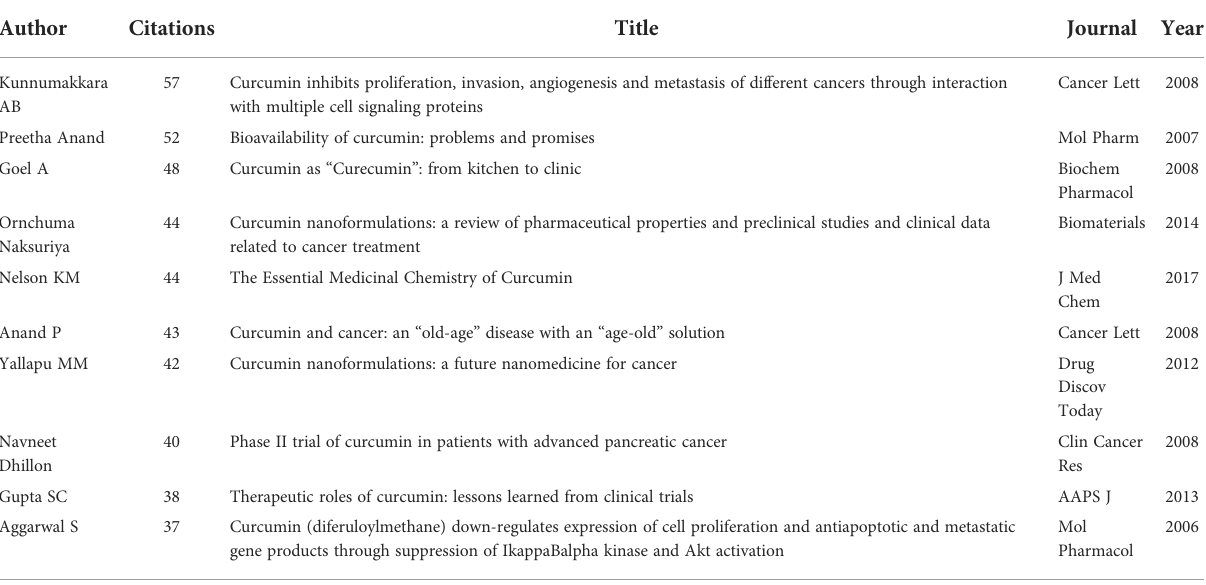
TABLE 5 The top 10 most co-cited references related to